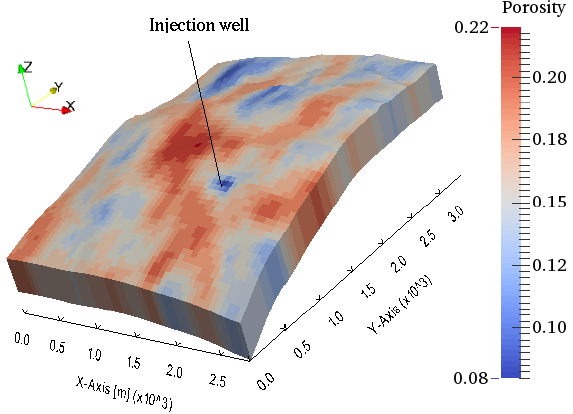
Figure 2. The spatial discretisation of the near-field Ketzin anticline used for the reactive transport model (northing direction is along the y axis). It comprises 2950 elements in one single layer, but with a 3-D structure following the topography of the target formation (magnified 5 times in the z direction). Depicted here is the hetero- geneous distribution of porosity, derived from the upscaled Ketzin geological